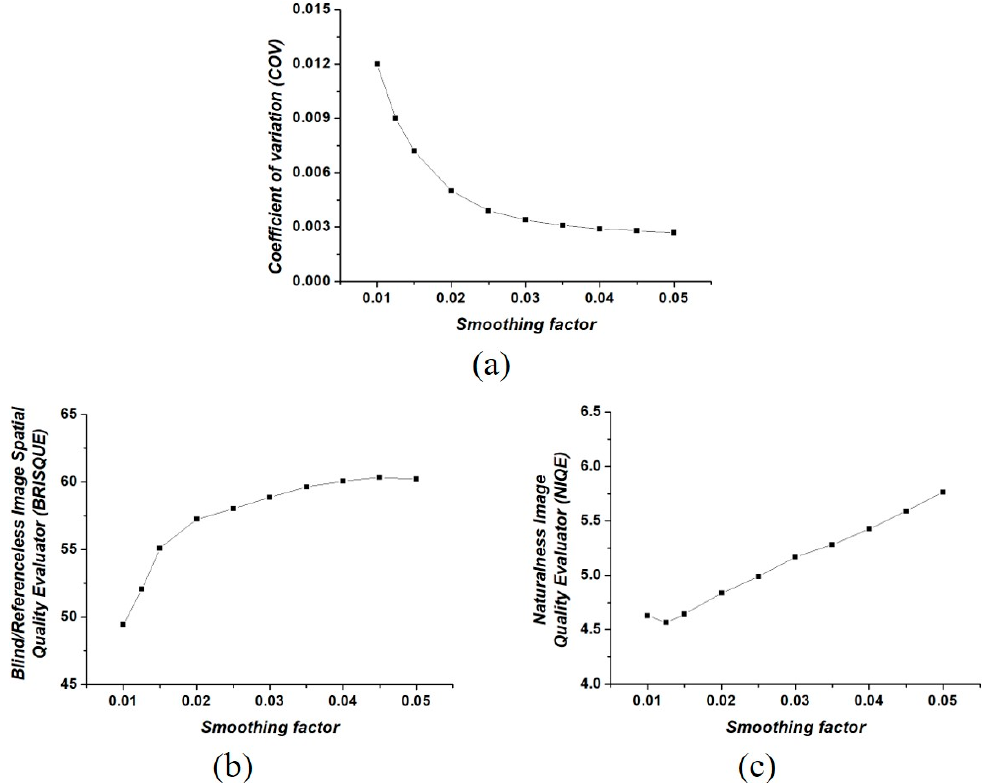
Figure 3. ( a ) Coefficient of variation (COV), ( b ) blind/referenceless image spatial quality evaluator (BRISQUE), and ( c ) natural image quality evaluator (NIQE) results of filtered color LM images using the FNLM algorithm with various smoothing factors.